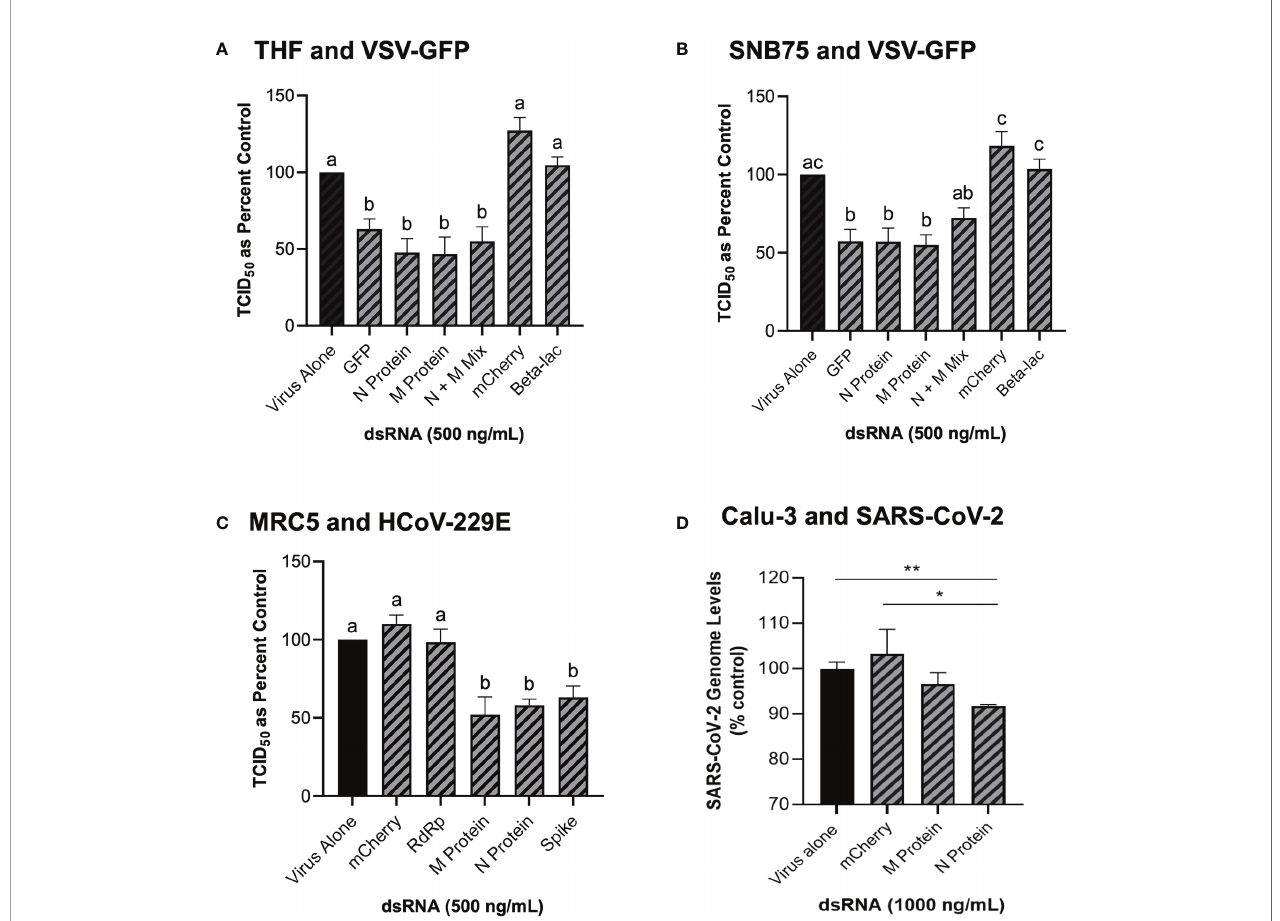
FIGURE 4 | Soaking cells with long dsRNA of viral genes can induce knockdown of the complementary virus. Both THF (A) and SNB75 (B) cells were pre-soaked for 2h with either DPBS alone, 500 ng/mL of the mis-matched dsRNA controls (mCherry or Beta-lac), 500 ng/mL of VSV N protein dsRNA, 500 ng/mL of VSV M protein dsRNA or a mixture of 250 ng/mL N protein dsRNA with 250 ng/mL of M protein dsRNA before infection with VSV-GFP (MOI = 0.1) for 24h. MRC5 cells were pre-soaked for 2h with either DPBS alone, 500 ng/mL of the mCherry mis-matched dsRNA sequence control or 500 ng/mL of dsRNA matching HCoV-229E sequences for either RdRp, M protein, N protein and the spike protein before 24h infection with HCoV-229E (MOI = 0.02) (C) . Calu-3 cells were pre-soaked for 2h with either DPBS alone, 1000 ng/mL of the mCherry mis-matched dsRNA sequence control or 1000 ng/mL of dsRNA matching SARS-CoV-2 sequences for either M protein and N protein prior to 24h infection with SARS-CoV-2 (MOI = 1.0) (D) . Error bars represent +SEM, and each data point represents the average of 6 independent replicates. A p-value of less than 0.05 was considered to be statistically signi fi cant and different letters represent signi fi cant differences. For the SARS- CoV-2 data, a p-value of less than 0.01 is represented by a ** symbol and a p-value of less than 0.05 is represented by a * symbol when compared only to the control